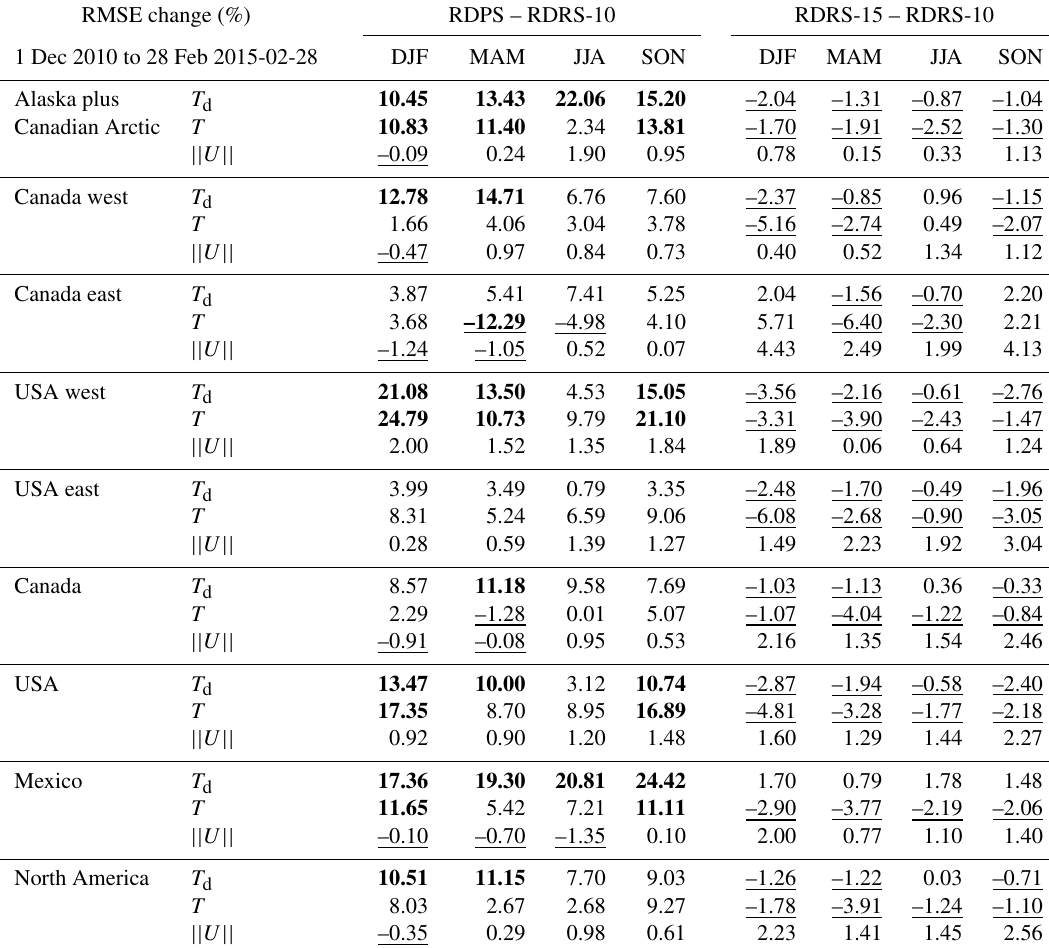
Table 5. Summary by seasons of average changes (in %) of RMSE (against SYNOP observations) between operational RDPS, RDRS-10 and RDRS-15 for 2011–2014 years. For each season, results are based on a combination of 6 to 17h lead time from integrations starting at 00:00 and 12:00UTC. Changes of more than 10% are shown in bold; negative values are